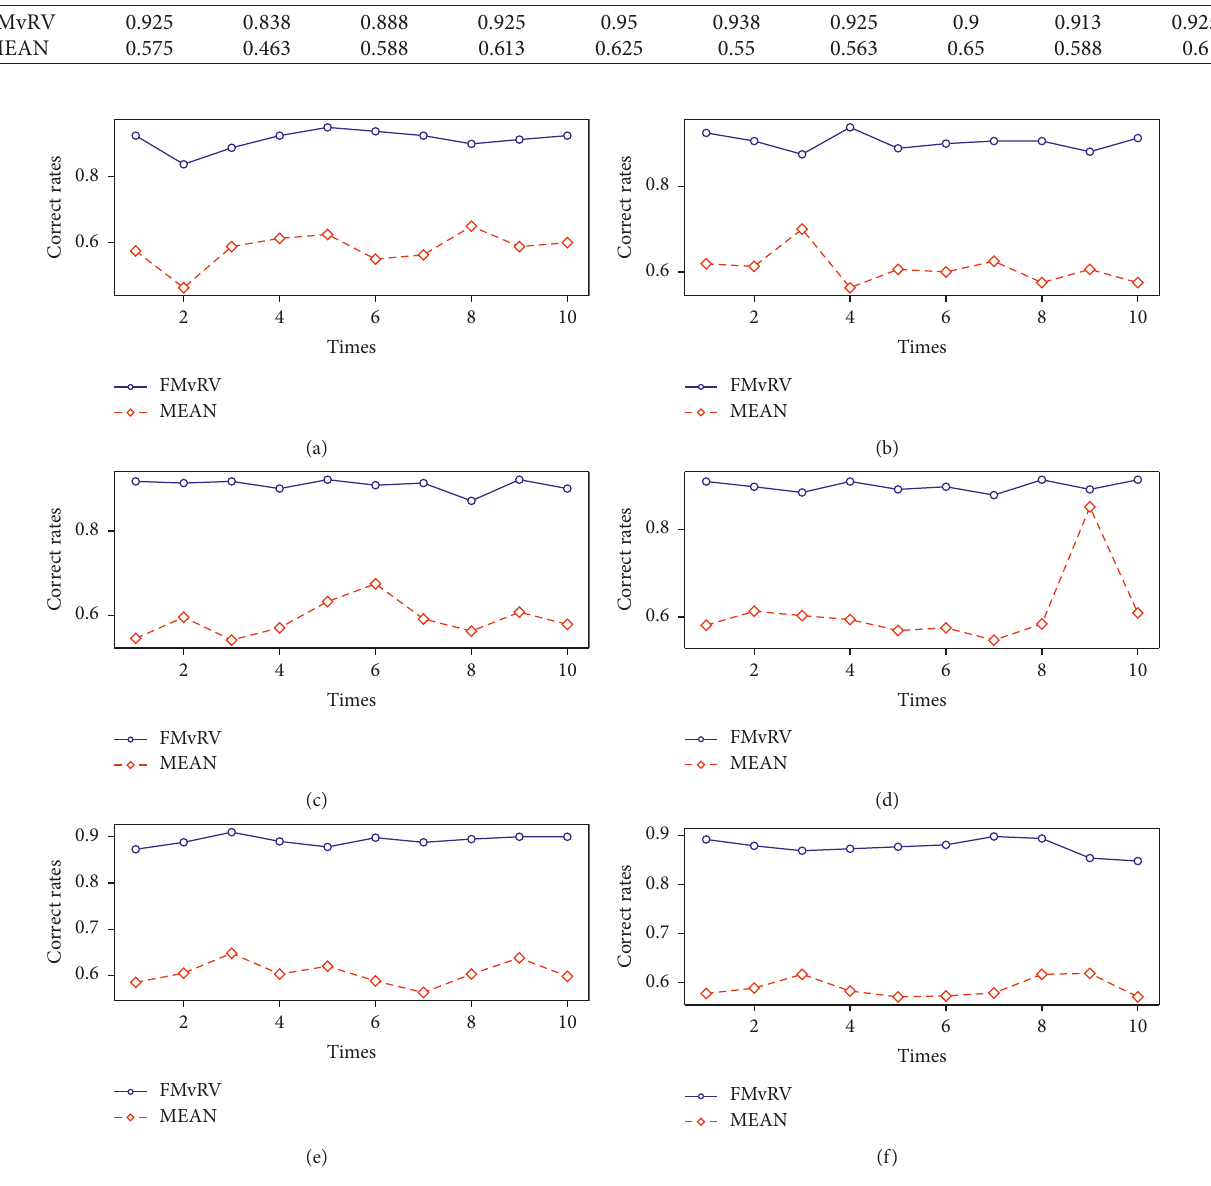
Table 12: Comparison of the correct rates of Algorithms FMvRV and MEAN in terms of AB200 with 5% missing values.